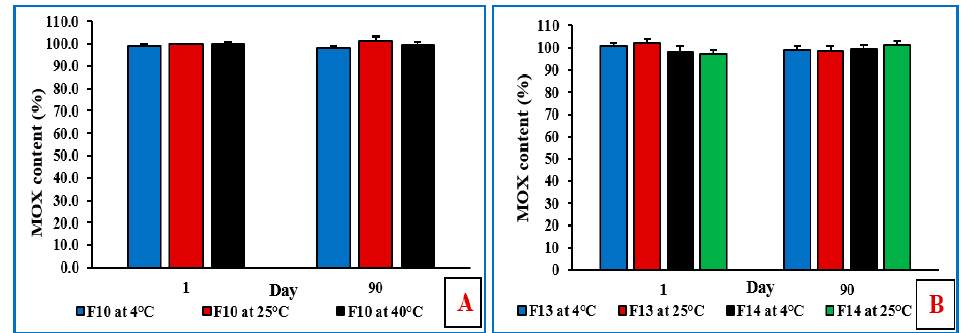
Figure 7. ( A ) Drug content (%) of F10 formulation at 4 °C, 25 °C, and 40 °C; and ( B ) drug content (%) of F13 and F14 formulations at 4 °C and 25 °C over three months of storage (mean ± SD, n =3).